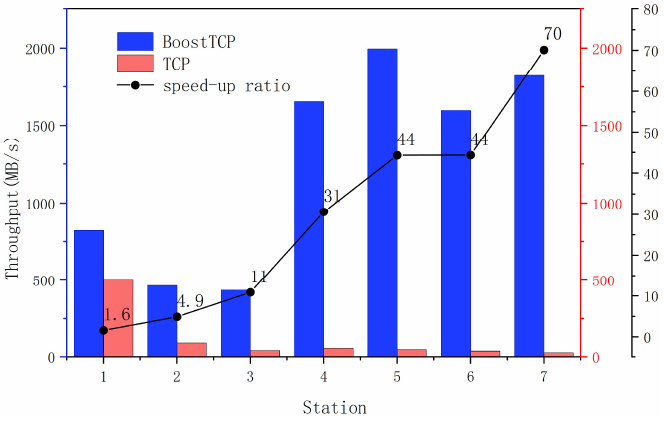
Figure 16. The actual network test results of the BoostTCP and ordinary TCP.